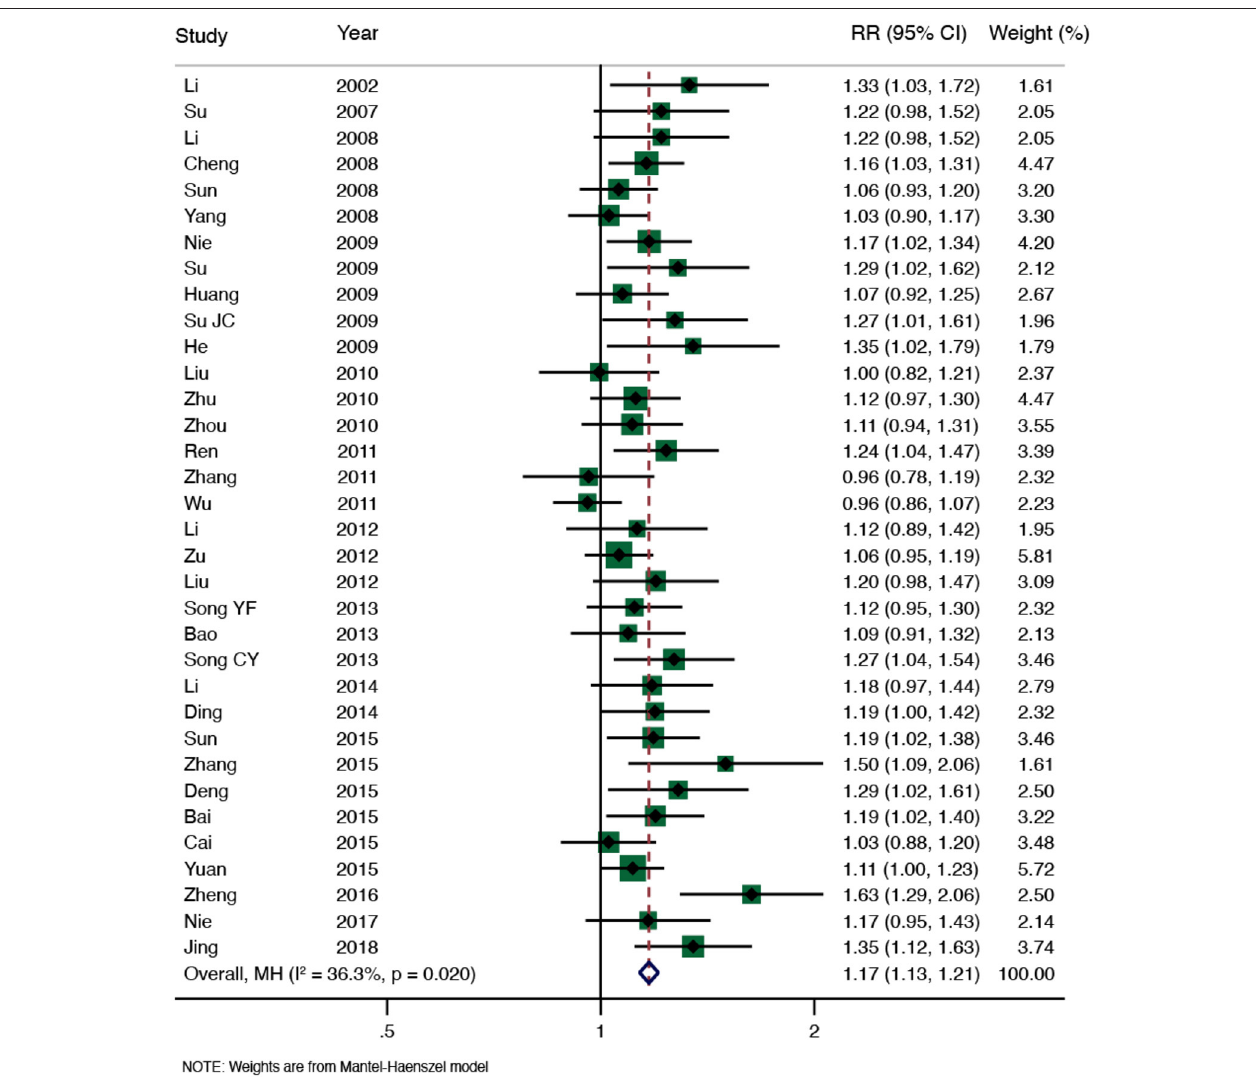
FIGURE 3 | Meta-analysis of total effectiveness rate (moxibustion for